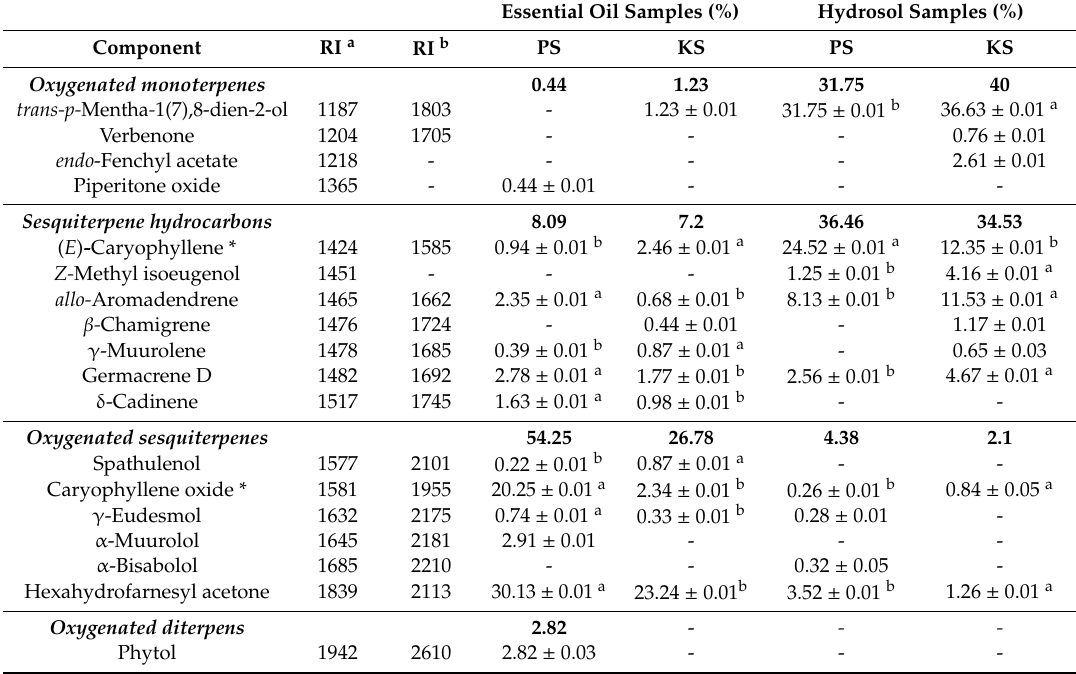
Table 1. Chemical composition of the essential oil (% ± SD) and hydrosols (% ± SD) from the two samples from aerial parts of V. saturejoides Vis. ssp .